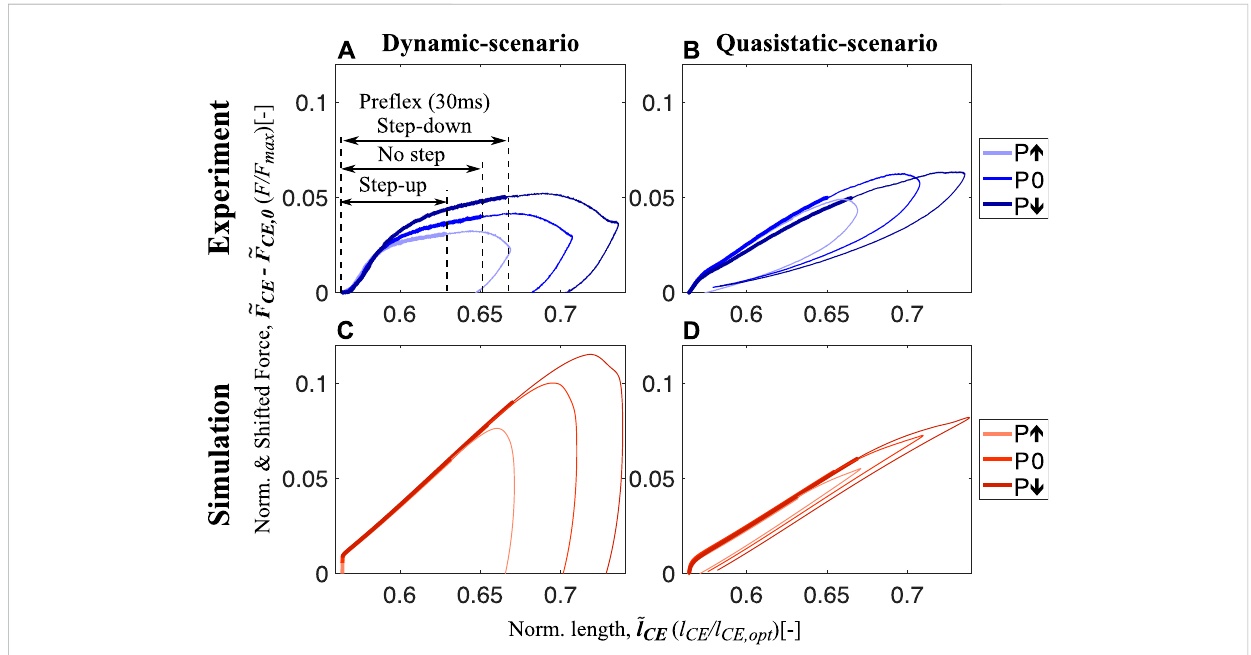
FIGURE 3 Shifted work loops for dynamic-scenario and quasistatic-scenario analysis step-up (P ↑ ), no (P0) and step-down (P ↓ ) perturbations for both experiments (A,B) and simulations (C,D) at 15% activity level (work loops for 5% and 25% are shared in Supplementary Figures S4, S5, respectively). The experimentaldatapresentedon (A,B) show themeanofallexperimentaltrials.Fromtouchdowntotoe-off, allstretch-shorteningcycleloopsareplotted in the clockwise direction, and the thick and thin sections of the loops represent the pre fl ex and remaining part of the stretch-shortening cycle, respectively. The pre fl ex stretch gets longer from step-up to step-down perturbation since the muscle stretches faster in the same amount of time. The force-time curves for all experimental conditions with standard deviations can be found in Supplementary Figure S6 and Supplementary Figure S7 for dynamic-scenario and quasistatic-scenario,